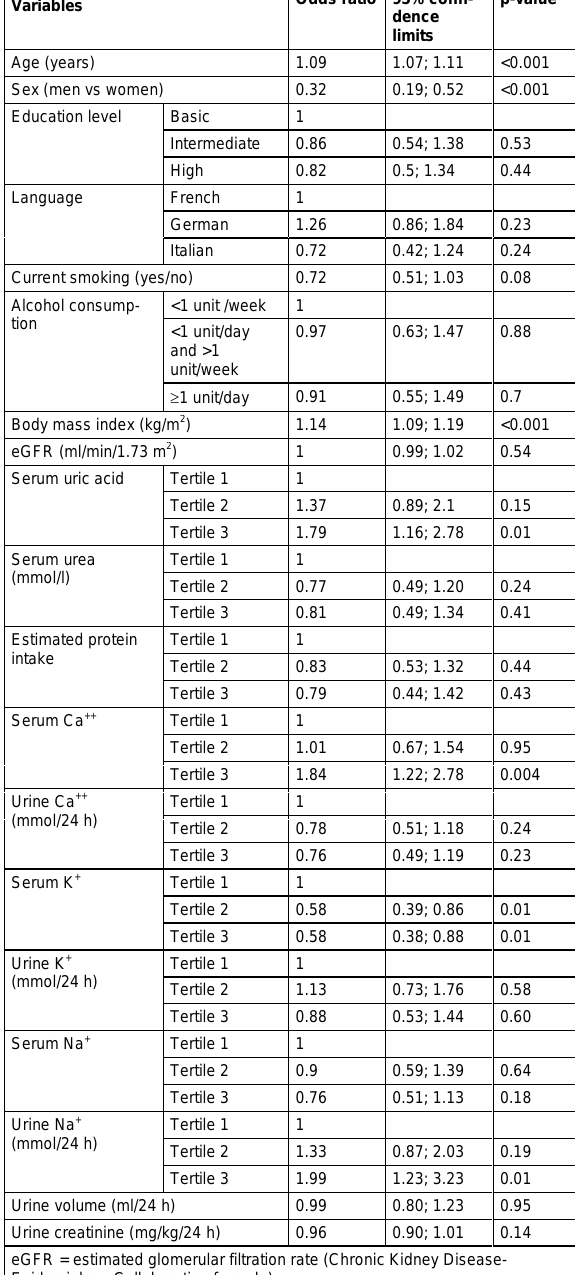
eGFR = estimated glomerular filtration rate (Chronic Kidney Disease- Epidemiology Collaboration formula) All tertiles are sex-specific (i.e., they were generated separately for women and for men). The p-values from the likelihood ratio test are: p = 0.09 for linguistic region; p = 0.03 for serum uric acid tertiles; p = 0.003 for serum Ca ++ tertiles; p = 0.03 for serum urea tertiles; p = 0.01 for serum K + tertiles; p = 0.02 for urine Na + tertiles; p >0.10 for serum Na + tertiles, urine K + tertiles, urine Ca ++ tertiles, education level, reported alcohol consumption and estimated protein